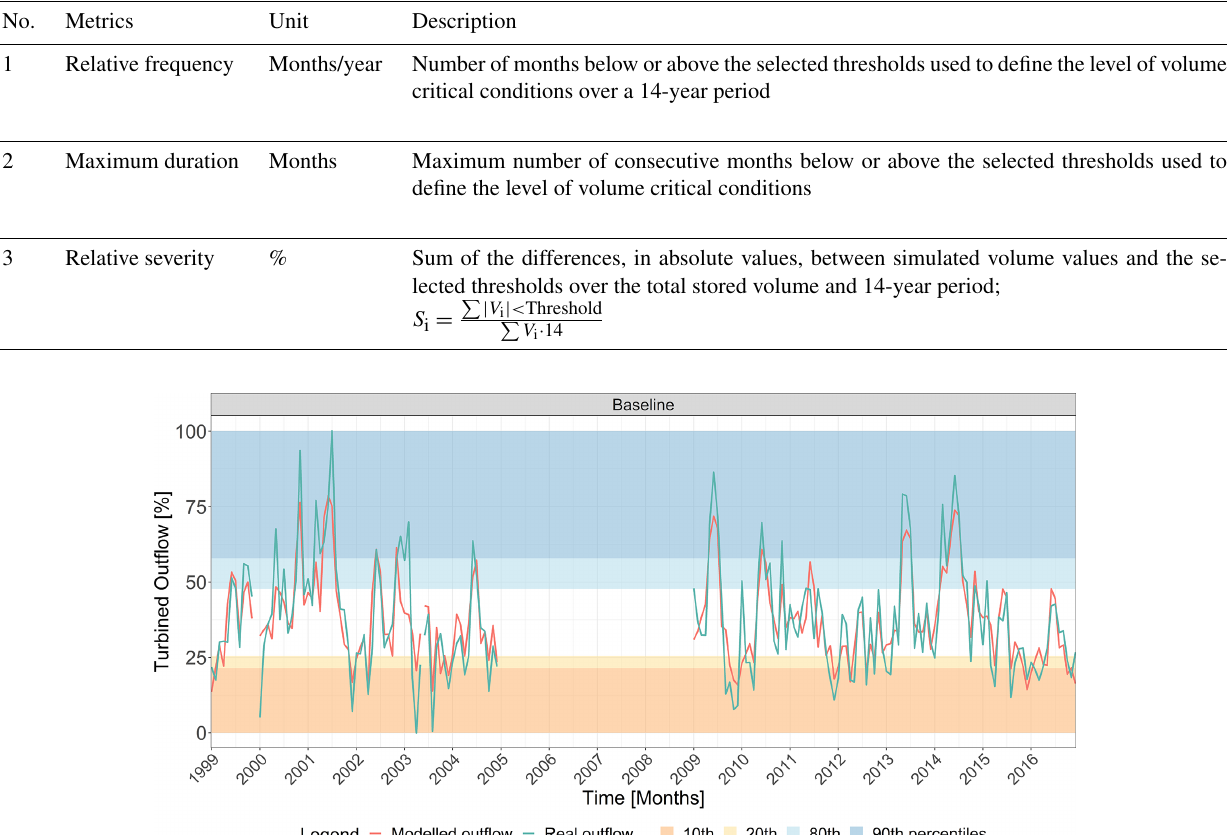
Figure 3. S. Giustina water diverted to the turbines from 1999 to 2016. Modelled (red line) and real (green line) values. Adjusted R 2 = 0.75, mean RMSE = 16.57Mm 3 . Coloured bands outline areas of values lower than the 10th and 20th and greater than the 80th and 90th per- centiles. For an interpretation of the references to colour in this figure legend, the reader is referred to the web version of this